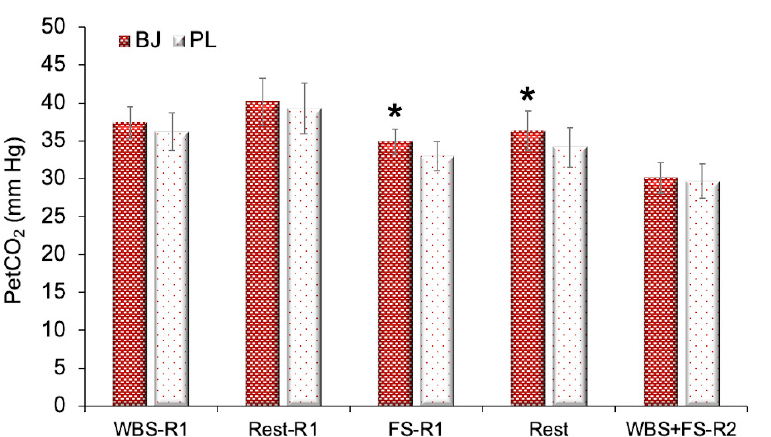
Figure 6. Differences between beetroot juice intake and the placebo in the partial pressure of end-tidal carbon dioxide (PetCO 2 ) ( n = 11). Abbreviations used: BJ: beetroot juice; FS-R1: full squat during the first routine; PL: placebo; WBS-R1: wall ball shots during the first routine; WBS+FS-R2: wall ball shots plus full squat during the second routine (without a rest). Data are provided as mean and error bars as 95% confidence intervals. * Significant increase in the PetCO 2 after BJ intake compared with PL ( p < 0.001).